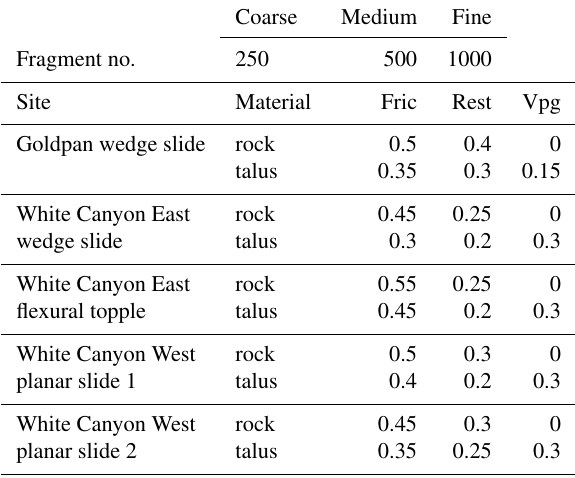
Table 1. The material coefficients used for each of the five rockfall event simulations. The fragmentation levels selected for the 15 sim- ulation iterations run for the White Canyon East wedge sliding event are also included. Fric indicates Friction and Rest indicates Restitu- tion. Coarse Medium Fine Fragment no. 250 500